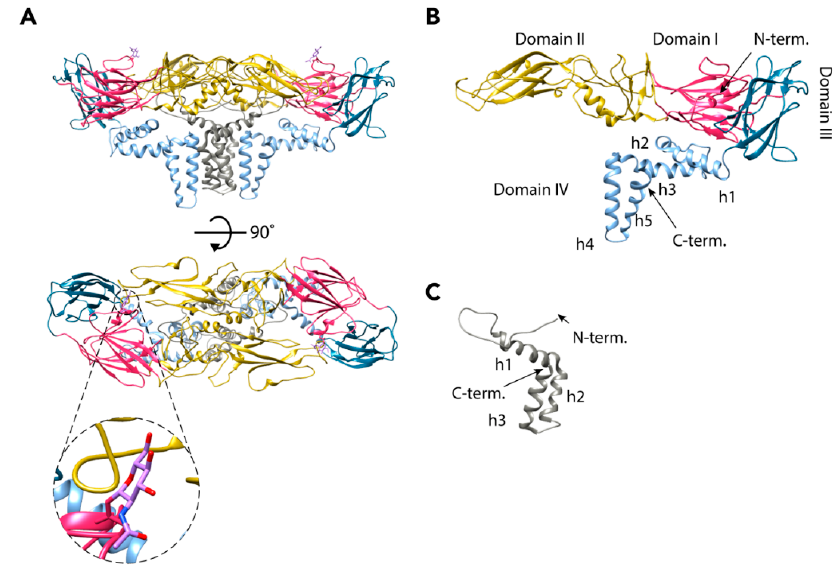
Figure 2. Ribbon representation of the E and M proteins as they are found in the TBEV virion. ( A ) Heterotetramer of two E and two M proteins. E proteins are coloured according to domain: red (I), yellow (II), blue (III), and light blue (IV), and M proteins are shown in grey. Zoom-in caption shows the stick representation of an Asn154 glycosylation site (pink) with an N-acetylglucosamine attached (violet). ( B ) The structure of the E protein monomer coloured according to domains. The five helices of transmembrane domain IV are indicated. ( C ) The structure of the M protein monomer. The peripheral membrane helix and two transmembrane helices are indicated.